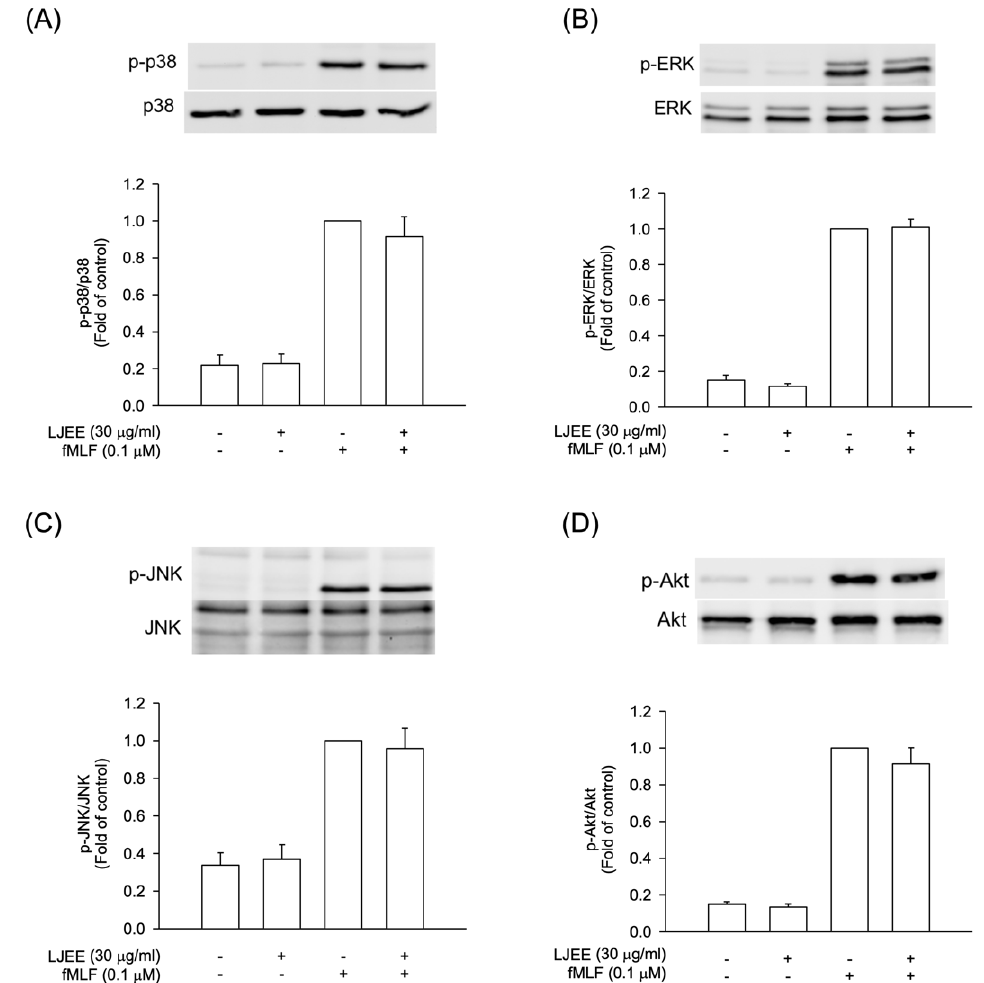
Figure 4. LJEE did not affect the phosphorylation of mitogen-activated protein kinases (MAPKs) and protein kinase B (Akt) in activated human neutrophils. Phosphorylation of ( A ) p38, ( B ) extracellular signal-regulated kinase (ERK), ( C ) c -Jun N -terminal kinase (JNK), and ( D ) Akt were analyzed by immunoblot, using antibody against the phosphorylated and total protein. All data are shown as the mean ± S.E.M. ( n = 6 or 7).